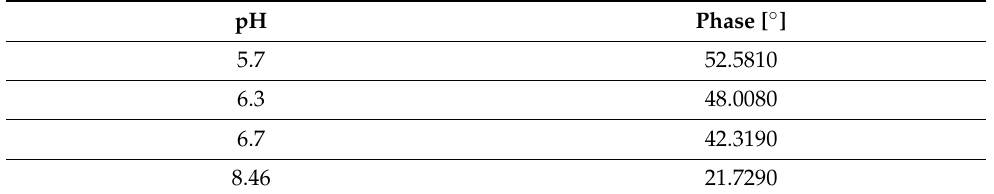
Table 1. Calibration parameters for pH